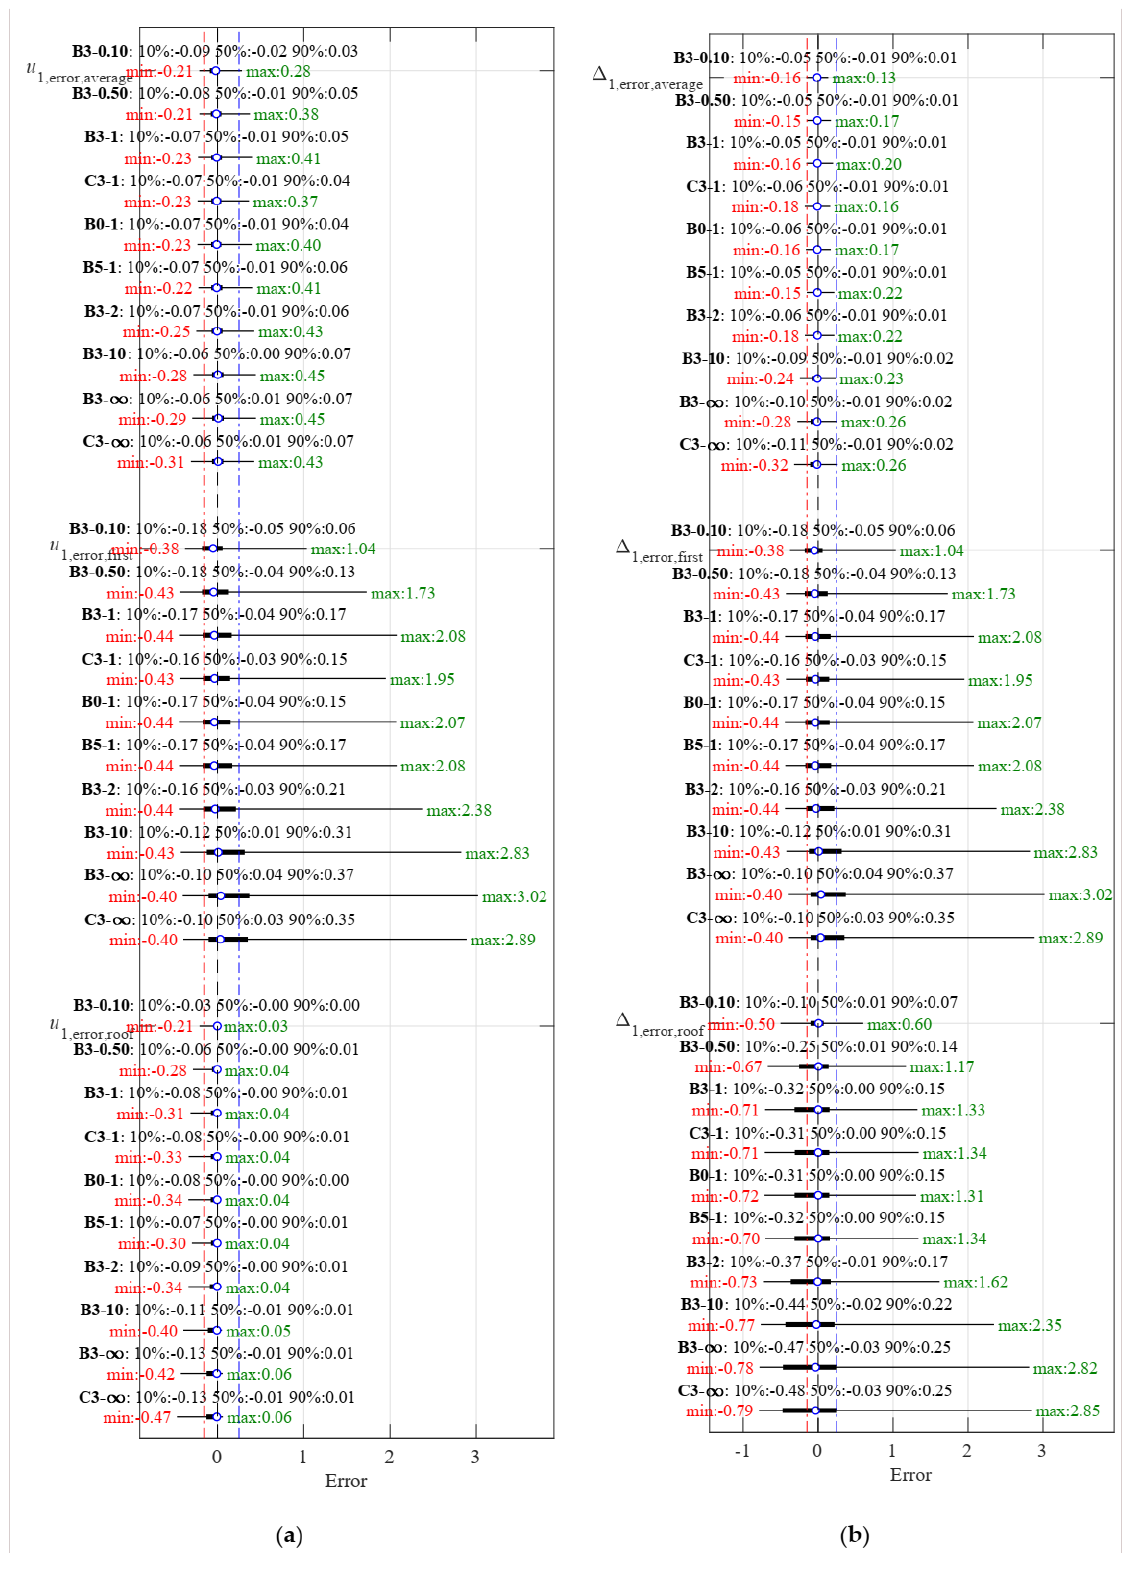
Figure A3. Bar plot for error type 1, average of stories, first story and roof: ( a ) relative displacement u error,1 ; ( b ) inter-story drift ∆ error,1